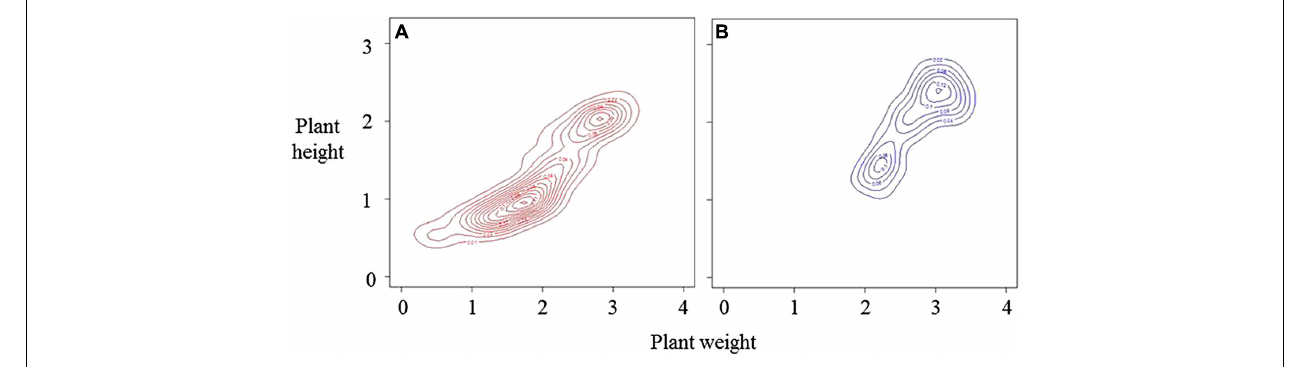
FIGURE 2 | Bivariate distributions of height and weight on the same arbitrary scales for a developing population over two time periods,A the younger stage, and B (based onTurley and Ford, 2011). The distributions are represented by density estimations using kernel smoothing (Wand and